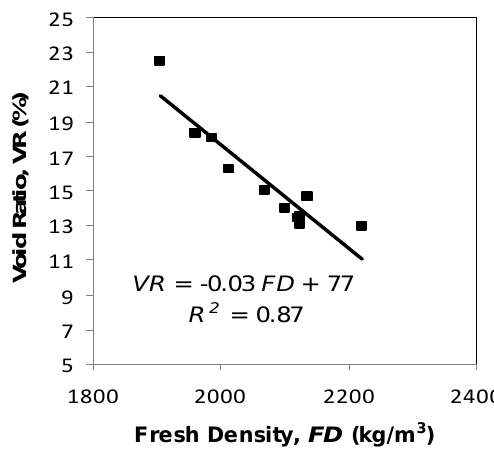
Figure 2. Relationship between void ratio and fresh density of PCPC